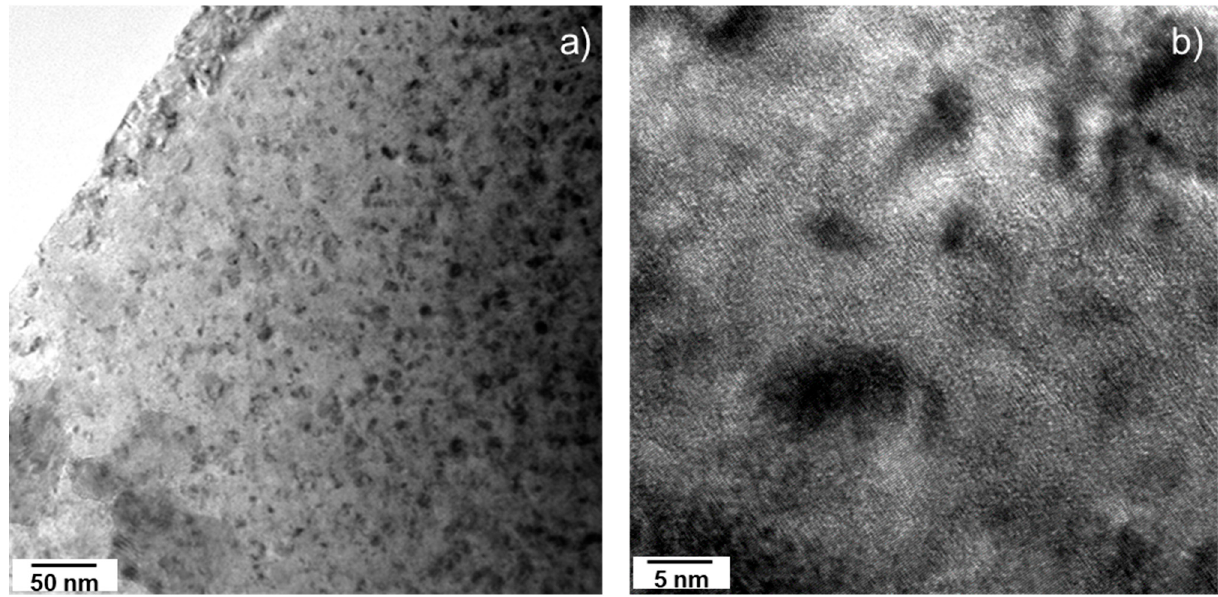
Figure 9. TEM bright field micrographs of sample UPuO-10 (4 dpa) showing ( a ) dislocation loops of 5 nm or more, and ( b ) details on higher magnification showing nanometric and sub-nanometric helium bubbles (white spots) and defect (interstitial) clusters (small black dots of 1–2 nm).